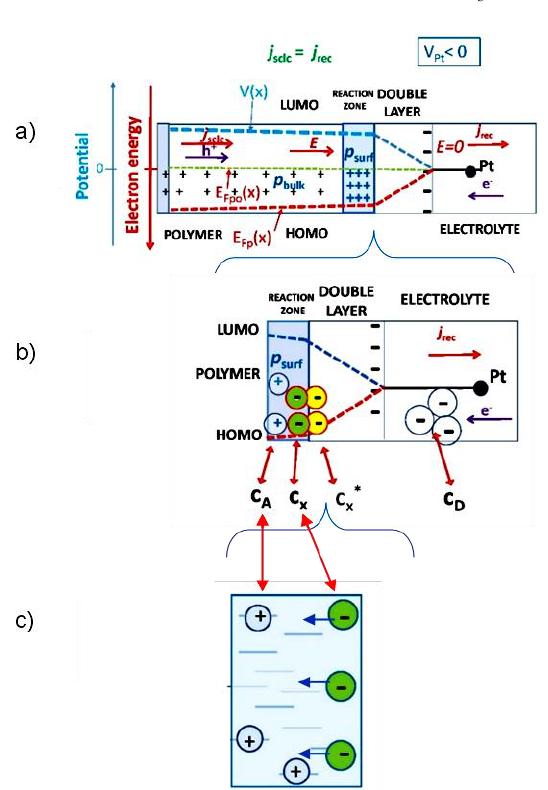
Figure 3. ( a ) Steady-state charge transport process in electrolyte/OS system for V Pt < 0 in OS with the established Fermi energy E Fp , the positively charged OS surface layer (reaction zone) with the surface concentration of holes p surf . To support the current via the system, the HOMO surface concentration of holes p surf is neutralized (reduced) by electronic s incoming from the electrolyte, forming the recombination current j rec . The created electric field strength E in the OS bulk is followed by the injected compensating holes from back contact, forming bulk current in the OS j SCLC ; ( b ) Enlarged “reaction” zone on the surface of OS where electronic s travel by hopping, discharging localized holes, which is enlarged in panel ( c